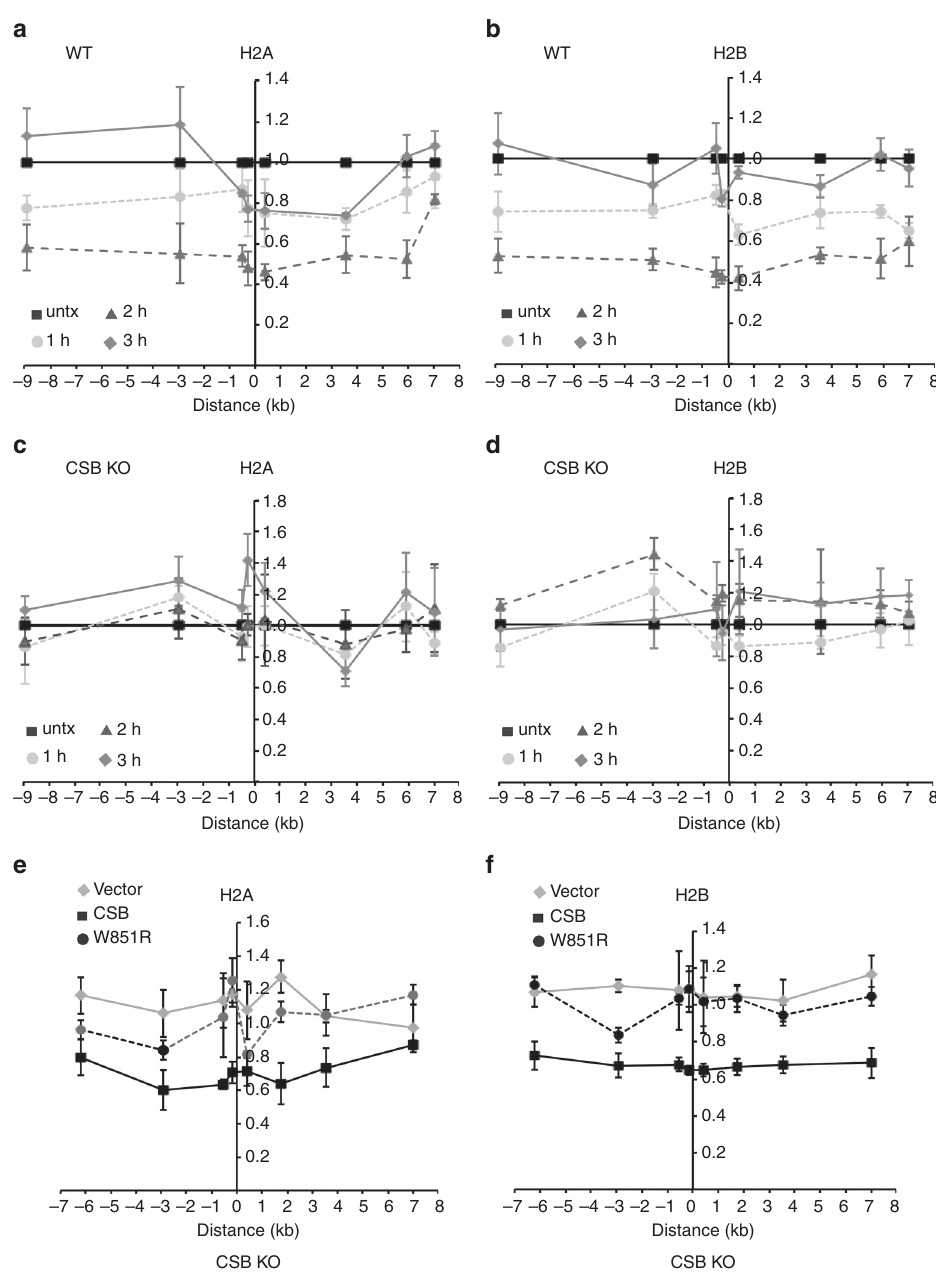
Fig. 5 CSB evicts histones from the chromatin surrounding I-PpoI-induced DSBs in vivo. a Relative occupancy of histone H2A in ddI-PpoI-expressing hTERT-RPE parental cells. Cells were either untreated (untx) or treated with Shield-1 and 4-OHT and then collected at indicated times. The x -axis represents the distance in kb upstream and downstream from the I-PpoI-induced DSB on chromosome 1, which was set as 0. The y -axis represents the relative occupancy of H2A of treated cells relative to untreated cells. Standard error of the mean (SEM) from three independent experiments are indicated. b Relative occupancy of histone H2B in ddI-PpoI-expressing hTERT-RPE parental cells. Both x - and y -axes are as described in a . SEM from three independent experiments are indicated. c Relative occupancy of histone H2A in ddI-PpoI-expressing hTERT-RPE CSB KO cells. Both x - and y -axes are as described in a . SEM from three independent experiments are indicated. d Relative occupancy of histone H2B in ddI-PpoI-expressing hTERT-RPE CSB KO cells. Both x - and y -axes are as described in a . SEM from three independent experiments are indicated. e Relative occupancy of histone H2A in ddI-PpoI-expressing hTERT-RPE CSB KO cells complemented with the vector alone, Myc-tagged wild-type CSB or Myc-tagged mutant CSB-W851R. Both x - and y -axes are as described in 5a. SEM from three independent experiments are indicated. f Relative occupancy of histone H2B in ddI-PpoI-expressing hTERT-RPE CSB KO cells complemented with the vector alone, Myc-tagged wild-type CSB or Myc-tagged mutant CSB-W851R. Both x - and y -axes are as described in a . SEM from three independent experiments are